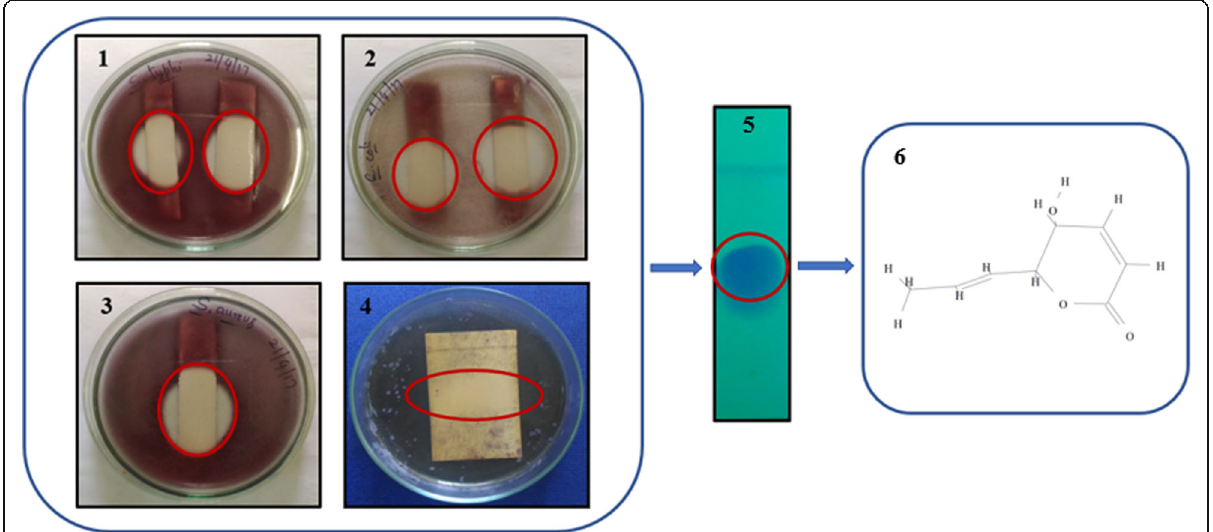
Fig. 4 TLC bioautography assay of purified phomalactone against selected microbial pathogens. (1) S. typhi , (2) E. coli , (3) S. aureus , (4) C. albicans , (5) TLC chromatogram (under UV light), and (6) structure of